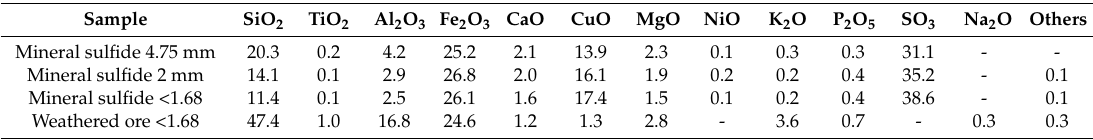
Table 1. Chemical composition (%) of the ore samples determined by energy dispersive x-ray fluorescence (EDXRF).